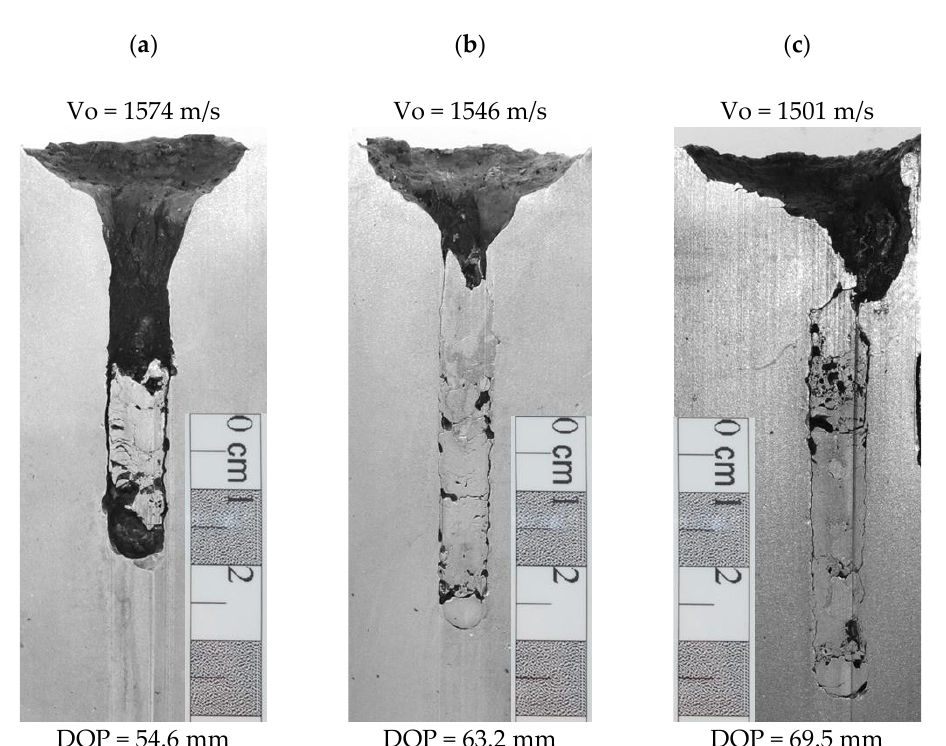
Figure 4. DOP tests against blocks of the RHA steel. The projectiles of diameter 4 mm and length to diameter (L/D) ratio: ( a ) 15, ( b ) 20 and ( c ) 24.